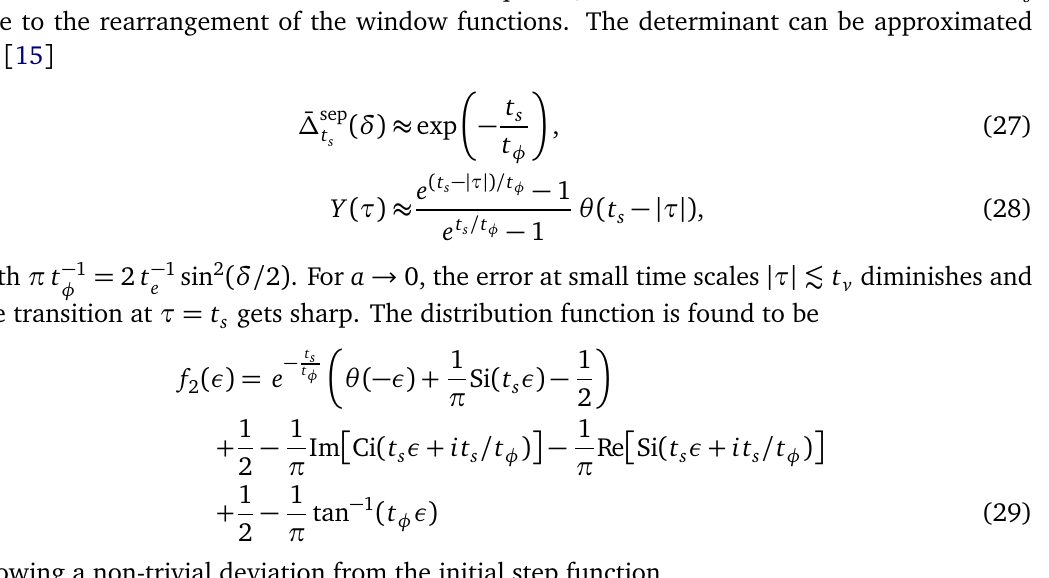
Figure 6: (top pannel) Normalized determinant ¯ ∆ τ ( δ ) with θ = 0.47 and t / t = 1 (black), 10 (red), 20 (blue) and 100 (green). (lower panel) The corresponding for t s v distribution function of mode 2 for t initial step function towards a smooth distribution